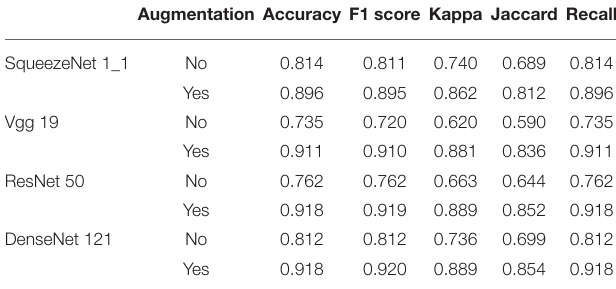
TABLE 5 | Ablation experiment of data